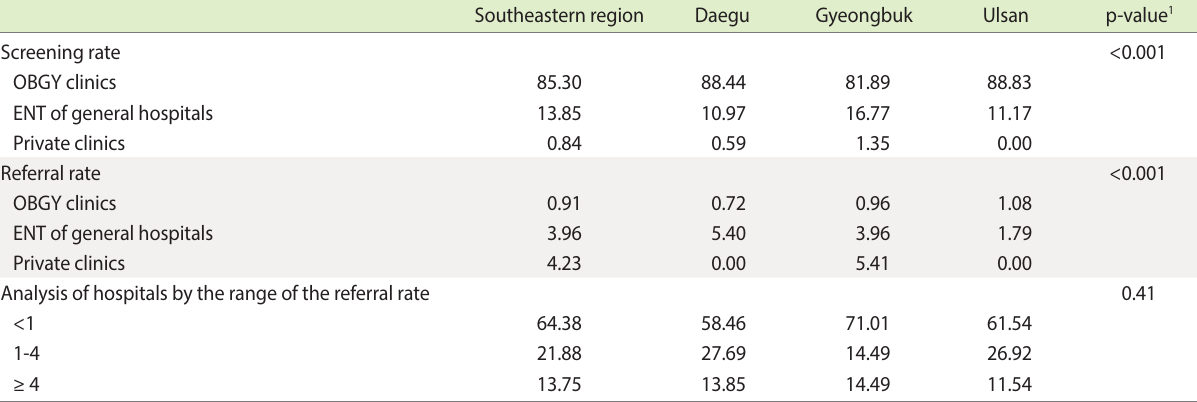
Table 2. Data by the type of designated institution for newborn hearing screening